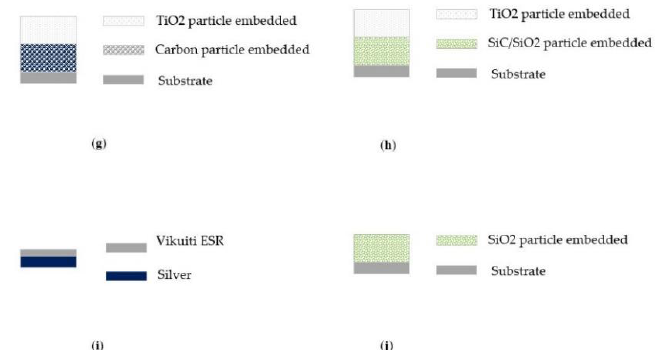
Figure 3. Schemes of some photonic structures. (a) 50 nm thick Ag is coated on Si substrate. Then, 4 alternative layers of TiO 2 and SiO 2 are added, and the thickness of each layer is 60 nm. Then 3 layers of TiO 2 and SiO 2 are added, each 300 nm thick [86]. (b) Radiative cooler of multilayer pyramidal nanostructure. The thickness of each SiO 2 layer is 1 μm and of each Al 2 O 3 layer is 2 μm [92]. (c) This photonic structure consists of 7 layers of SiO 2 and HfO 2 , on top of 200 nm thick Ag, 20 nm thick Ti and 750- μm thick Si substrate [70]. (d) A thermal emitter with multilayer arrays of symmetrically shaped conical metamaterial pillars. The thickness of aluminum layer is 30 nm and the thickness of germanium layer is 110 nm [90]. (e) A polymer silica mirror is produced by coating a 500 μm thick fused silica wafer with a 100- μm thick PDMS film on top and 120 nm thick silver film to reflect on the back [41]. (f) The radiative cooler consists of 2 photonic crystal emitters comprised of quartz and SiC. The reflector lies below the emitters contains three sets of five bilayers made of MgF 2 and TiO 2 . Silver serves as a substrate [89]. (g) A double layer coating with TiO 2 embedded on top and carbon black on bottom [40]. (h) A double layer coating with TiO 2 embedded on top and SiC or SiO 2 on bottom [85]. (i) Vikuiti Enhanced Specular Reflector (ESR) is all polyester and believed to consist of PET/ECDL pairs with ECDEL a Kodak copolyester. The back surface is coated with silver [38]. (j) The